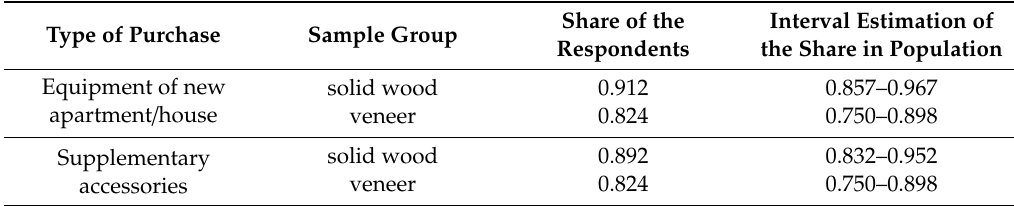
Table 5. The proportion of the respondents willing to purchase furniture made of birch wood or veneer with the thermal